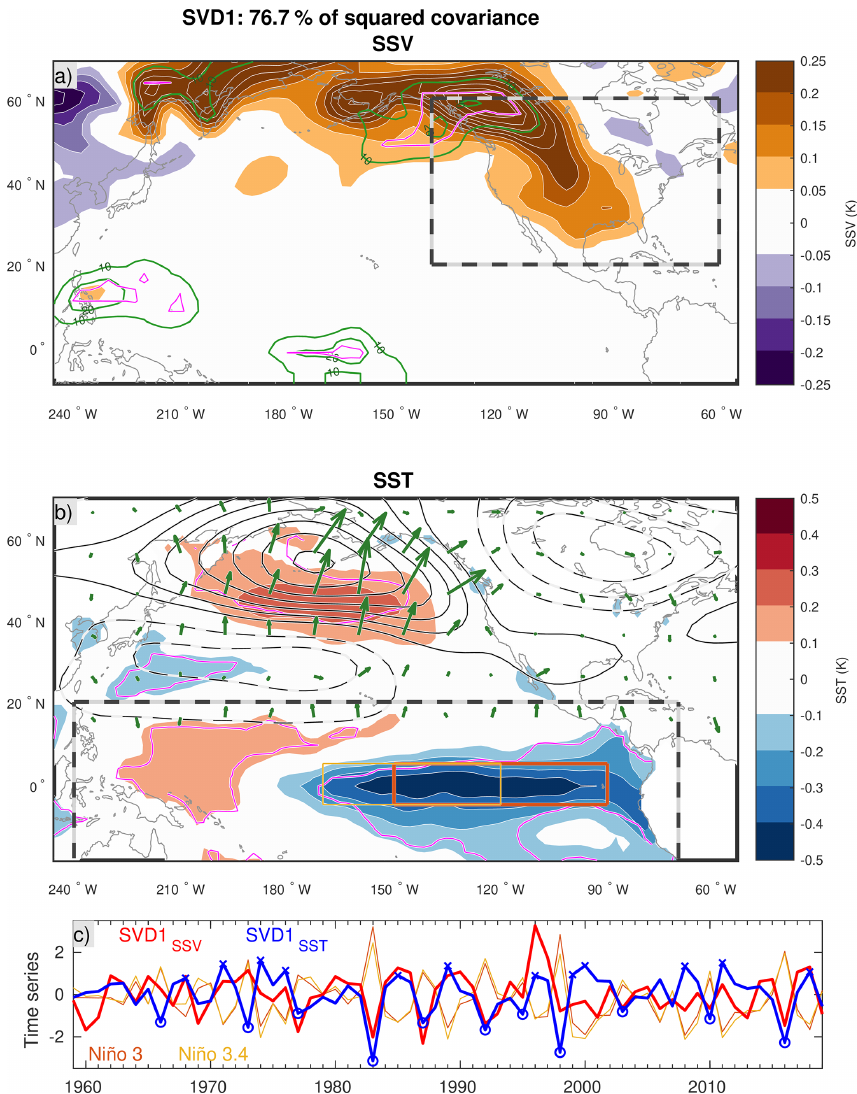
Figure 2. Wintertime anomaly patterns of (a) subseasonal SAT variability (SSV; 10–60d) and (b) winter-mean SST associated with the dominant mode of covariability (SVD1, corresponding to La Niña) between the two variables (color shadings; anomalies statistically sig- nificant at the α FDR = 0 . 1 significance level are contoured in magenta). The sectors used for the SVD analysis are bounded by bold dashed lines. The green contours superimposed on (a) indicate the fraction of interannual SSV variability explained by this mode with 10% contour intervals (solid and dashed contours are used for positive and negative values, respectively; the 0 line is omitted). Z 500 anomalies regressed onto SVD1 SST are superimposed on (b) with black contours (increment of 5m, solid and dashed for positive and negative anomalies, respec- tively). The corresponding wave-activity fluxes (Takaya and Nakamura, 2001) are shown with green arrows. A distance of 1 ◦ corresponds to a flux of 0.125m 2 s − 2 . (c) Anomaly time series of SSV (SVD1 SSV , red) and SST (SVD1 SST , blue) associated with SVD1. Two Niño indices are superimposed (domains used to compute these indices are illustrated over the SST pattern in panel b